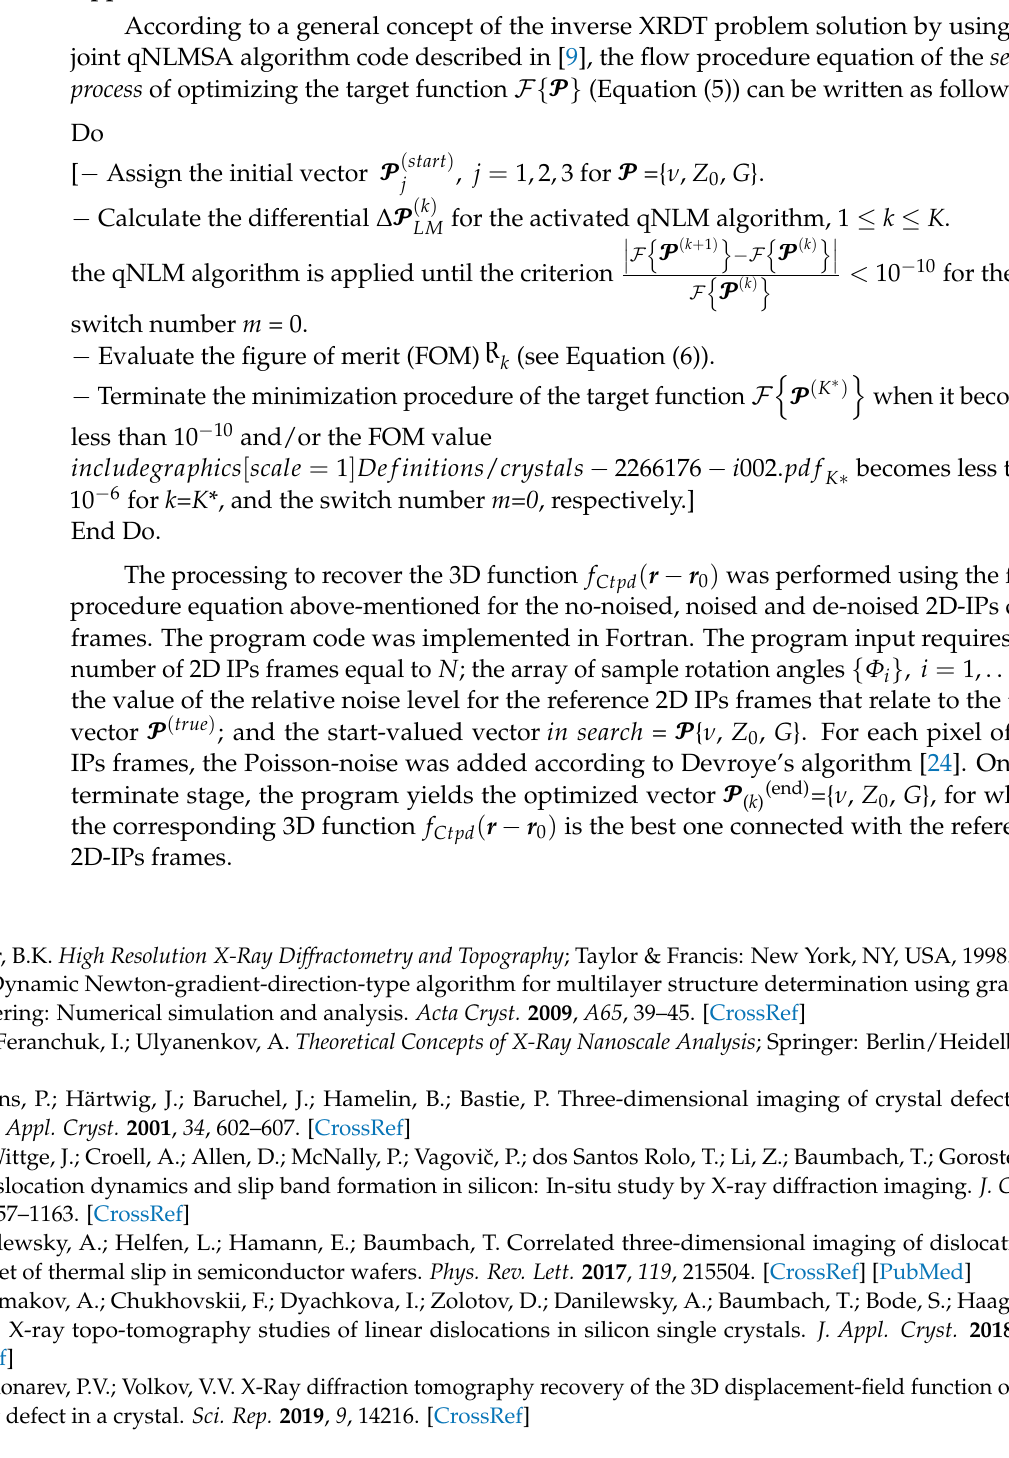
Figure 3. The 2D IPs: no- noise level (left), 4% -noise level (middle) and de-noised (right). The number of non-averaged IPs data frames is equal to 100. The sample rotation angles Φ are equal to {−20°, 0°, 20°}, respectively.